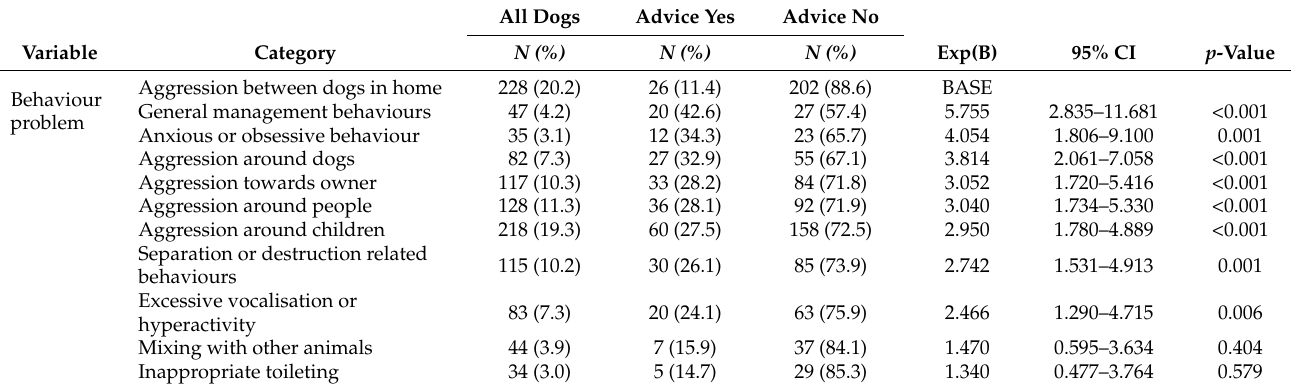
Table 3. Descriptive and univariable logistic regression statistics for association between behavioural problem and accep- tance of behavioural advice among dog behaviour-based relinquishment request calls to Wood Green, The Animals Charity between January 2017 and August